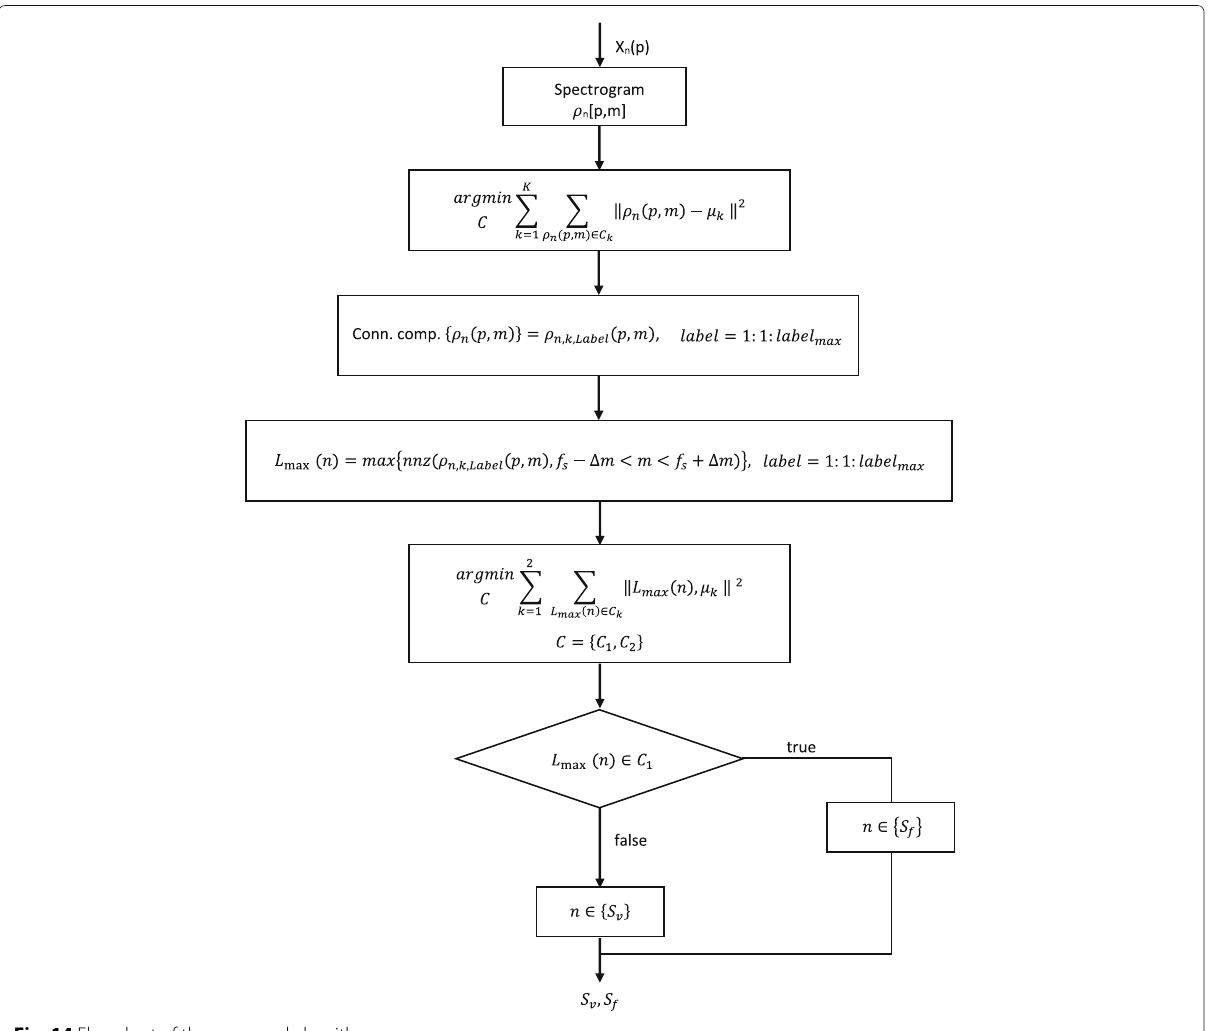
Fig. 14 Flowchart of the proposed algorithm